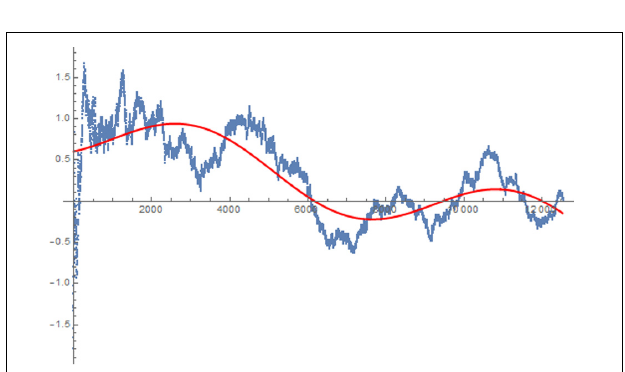
FIGURE 6 | Sequential Bayesian one-sample t -test analysis of the percentage of positive pictures obtained by the